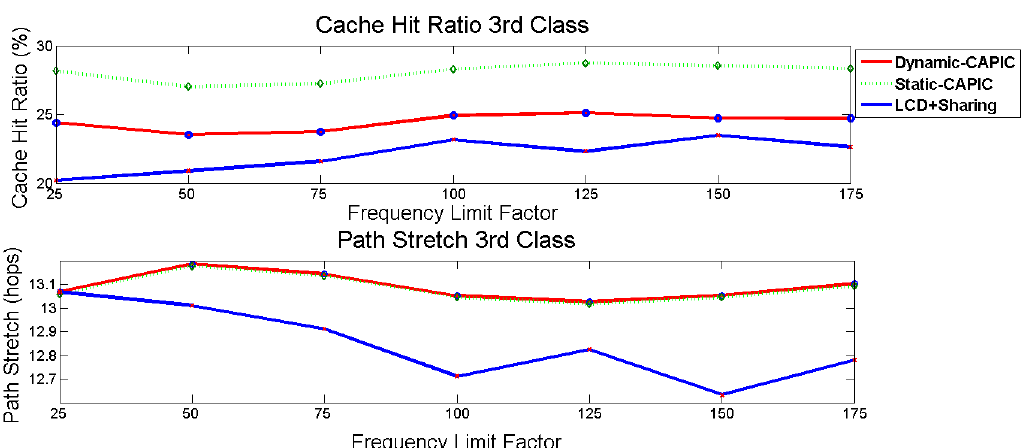
Figure 10. Cache hit ratio ( above ) and path stretch ( below ) 3rd class of Dynamic-CAPIC, Static-CAPIC, and LCD+sharing